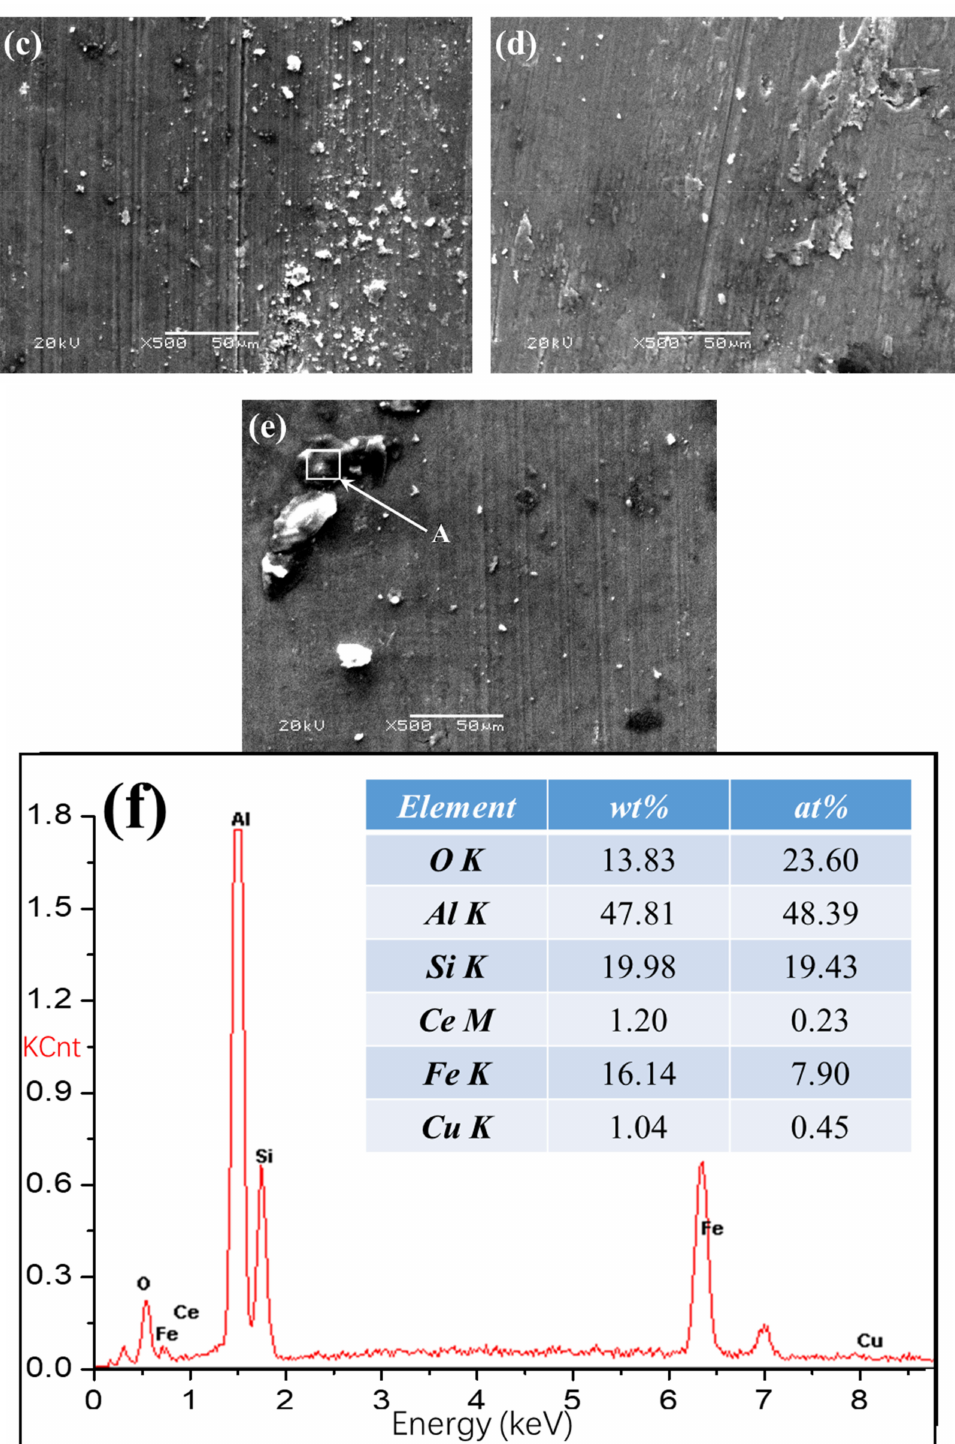
Figure 10. The SEM and EDS pictures of wear surface morphologies of SiCp / Al-Si Composites with 0.6 wt% CeO 2 under di ff erent loads: ( a ) 500 N; ( b ) 550 N; ( c ) 600 N; ( d ) 650 N; ( e ) 700 N; ( f ) the energy spectrum diagram of region A in Figure